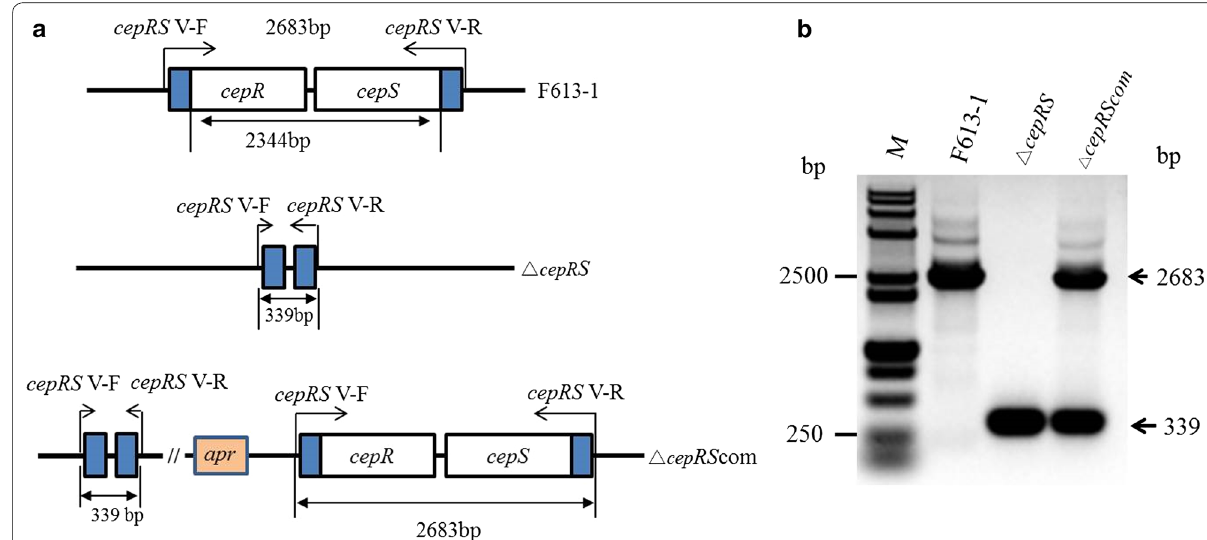
Fig. 1 Verification of cepRS mutant strain Δ cepRS . a Schematic representation outlining the construction of the cepRS deletion and complementation strains. b Polymerase chain reaction-based verification of the Δ cepRS and Δ cepRS com strains. M: DNA